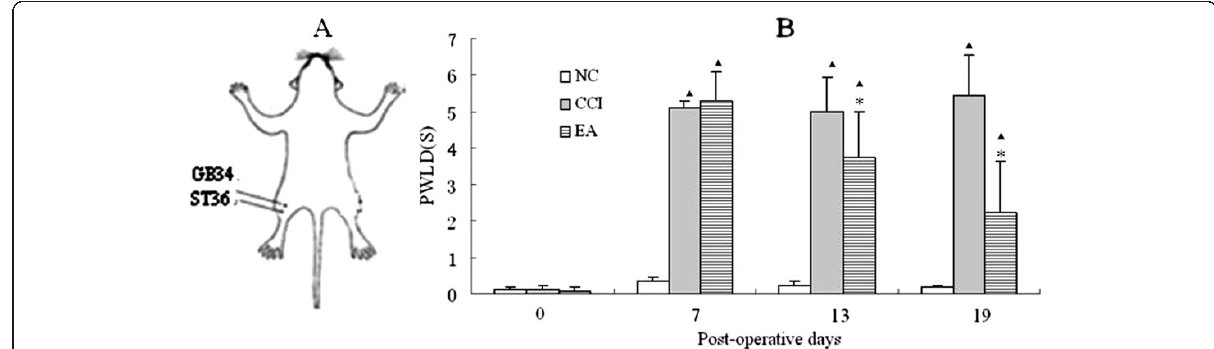
Figure 1 Schematic locations of the acupoints in rats and effects of EA on pain threshold (A) Schematic locations of the acupoints in rats, (B) Effects of EA on PWLD in rats of the NC, CCI and EA groups (n = 20 per group). PWLD was recorded before CCI, and on day 7,13 and 19 after CCI. Data are presented as mean ± SD. ▲ P < 0.05, compared with the NC group; * P < 0.05, compared with the CCI